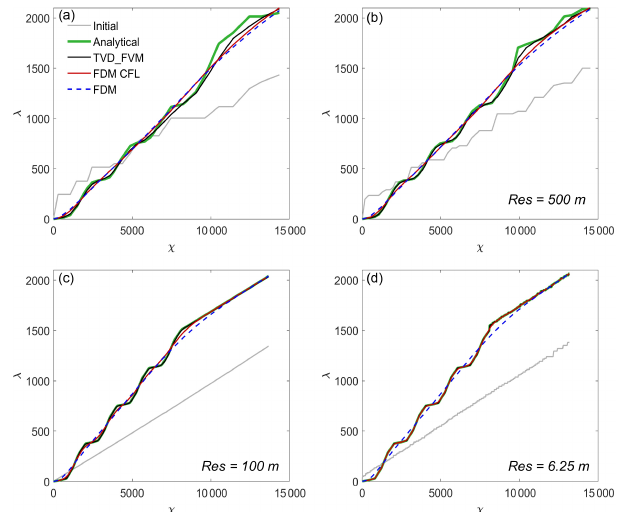
Figure 4. Comparison between different modeled resolutions for the river profile indicated in blue in Fig. 2. The green line is the analytical “true” solution, obtained with the slope patch method of Royden and Perron (2013). The full red line represents the first- order accurate implicit solution when the CFL<1, and the dotted blue line represents the first-order accurate implicit solution when the time step is left free. The implicit solutions where CFL<1 are simulated with a time step equal to the time step used for the TVD- FVM.